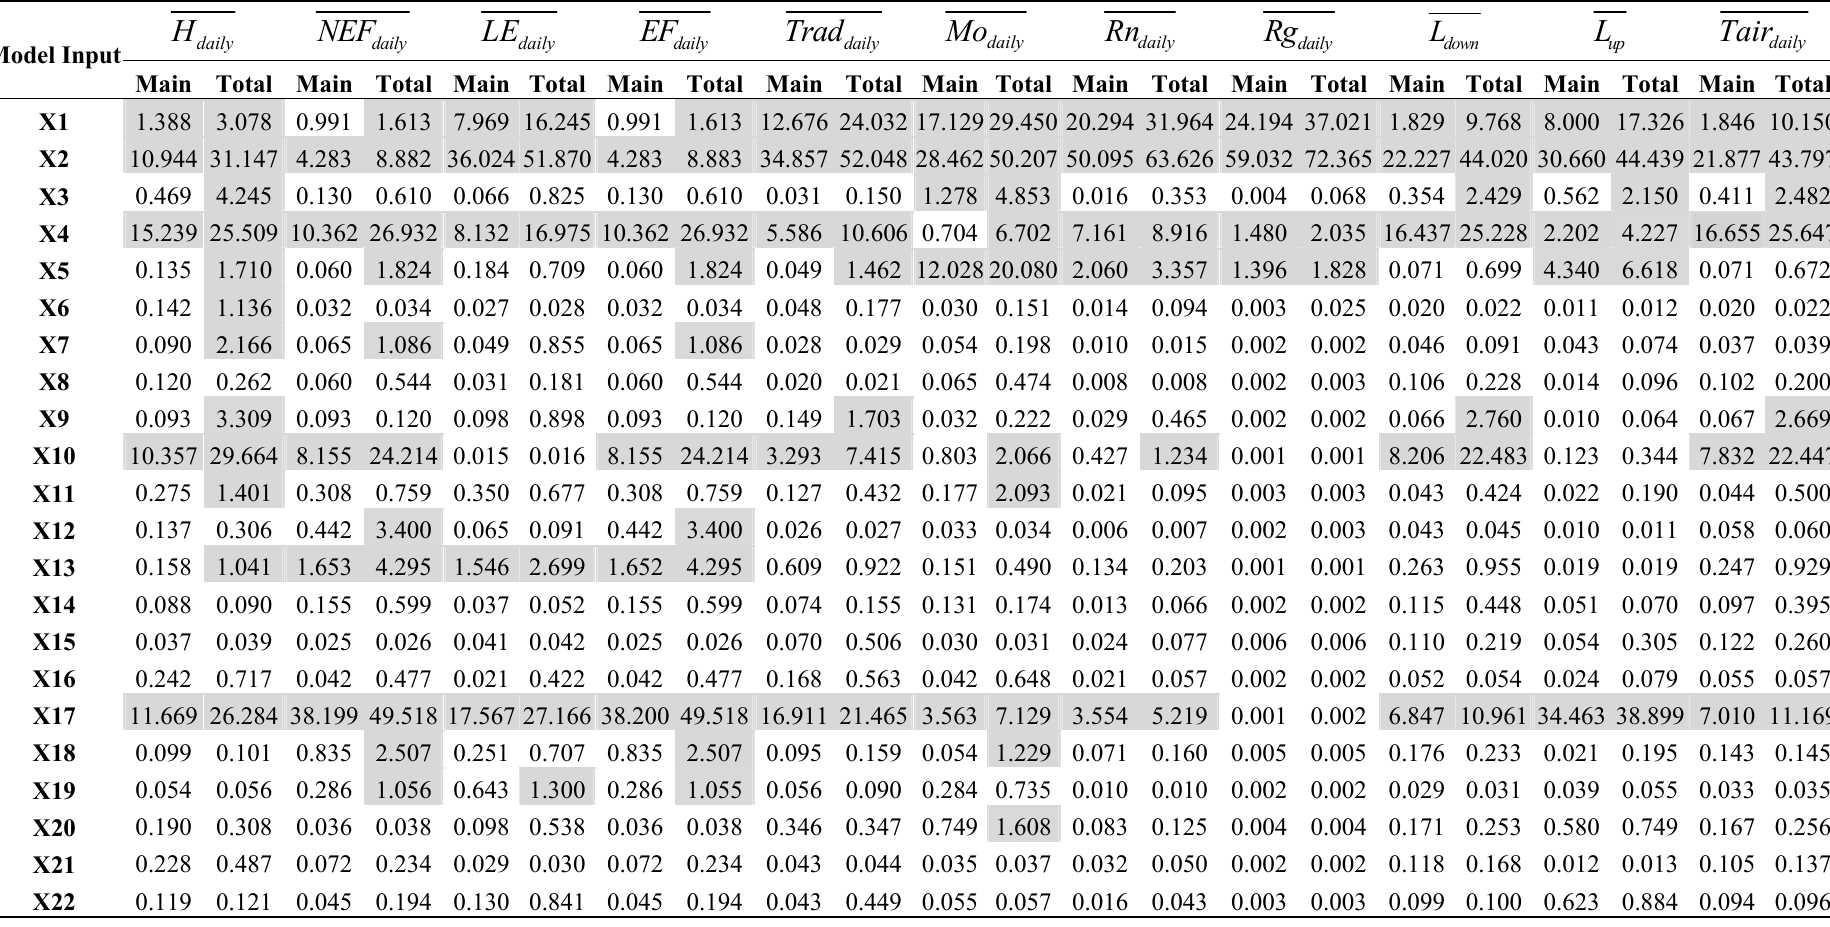
Table 6. Summarised results from the implementation of the BACCO GEM-SA method on the different outputs simulated by SimSphere using uniform PDFs at 11:30. Computed main (Main) and total effect (Total) indices by the GEM tool (expressed as %) for each of the model parameters are shown, whereas the last three lines summarise the percentages of the explained total output variance of the main effects alone (ME), the 1st order interactions only (1st) and the 2nd or higher order interactions only (>1st). Input parameters with a variance decomposition of greater than 1% are